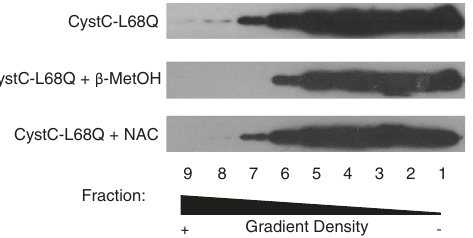
Fig. 3 N-acetylcysteine reduces L68Q-hCC density in sucrose-gradient ultracentrifugation. L68Q-hCC cell lysates were treated with β - mercaptoethanol ( β -MetOH) or n-acetyl cysteine (NAC) for 1 h at 37 °C. Lysates were layered on top of sucrose step gradients, ranging from 5% sucrose at the top (fraction 1) to 30% at the bottom (fraction 9) in 5% increments. Gradients were ultracentifuged in a swinging bucket rotor for 16 h at 4 °C and 246,000× g . Fractions were collected from gradients, proteins were precipitated with tricholoroacetic acid, and precipitated proteins were dissolved in PBS before analysis by SDS-PAGE under reducing conditions. Gels were blotted for cystatin C. The image is representative of three independent experiments and